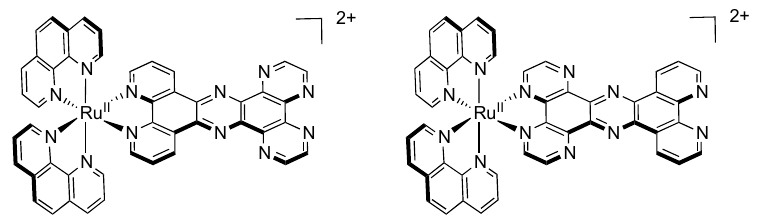
(PHEHAT)] 2+ (left) and [Ru(phen) 2